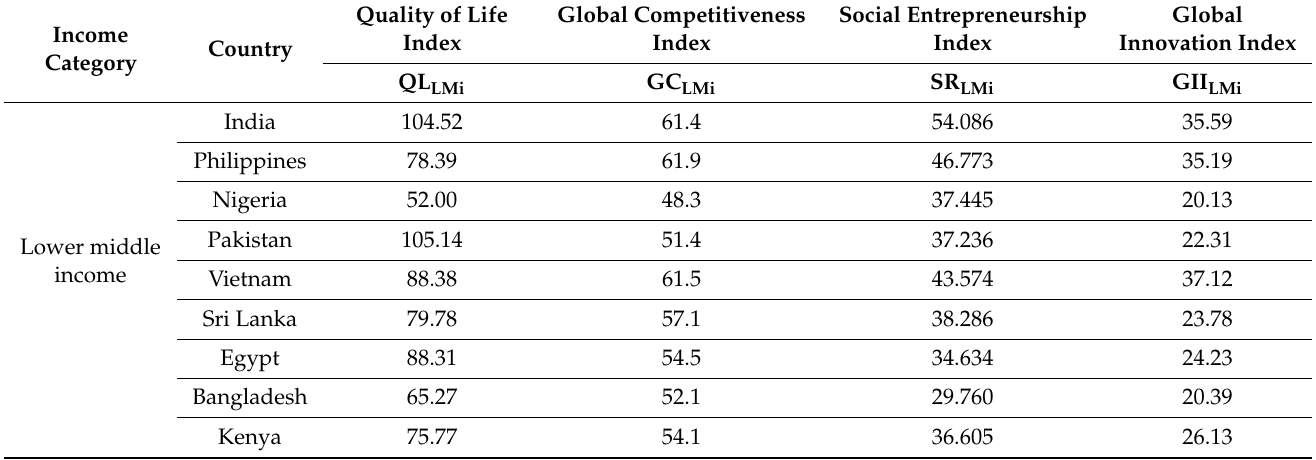
Table 2. Innovations, orientation at the consumer market: competitiveness and corporate responsibility in countries with lower middle income in 2021, points